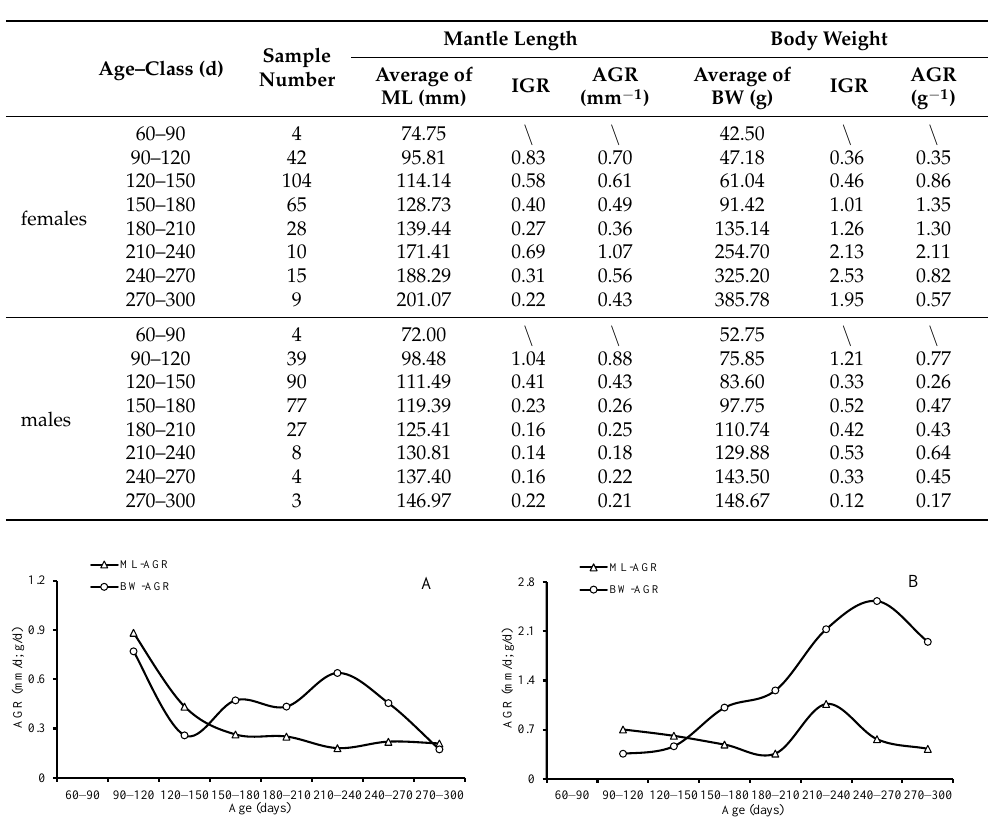
Table 3. Instantaneous relative growth rates (IGRs) and absolute growth rate (AGR) for mantle length (ML) and body weight (BW) for the winter–spring group of S. oualaniensis in the waters of the Xisha Islands of the South China Sea.